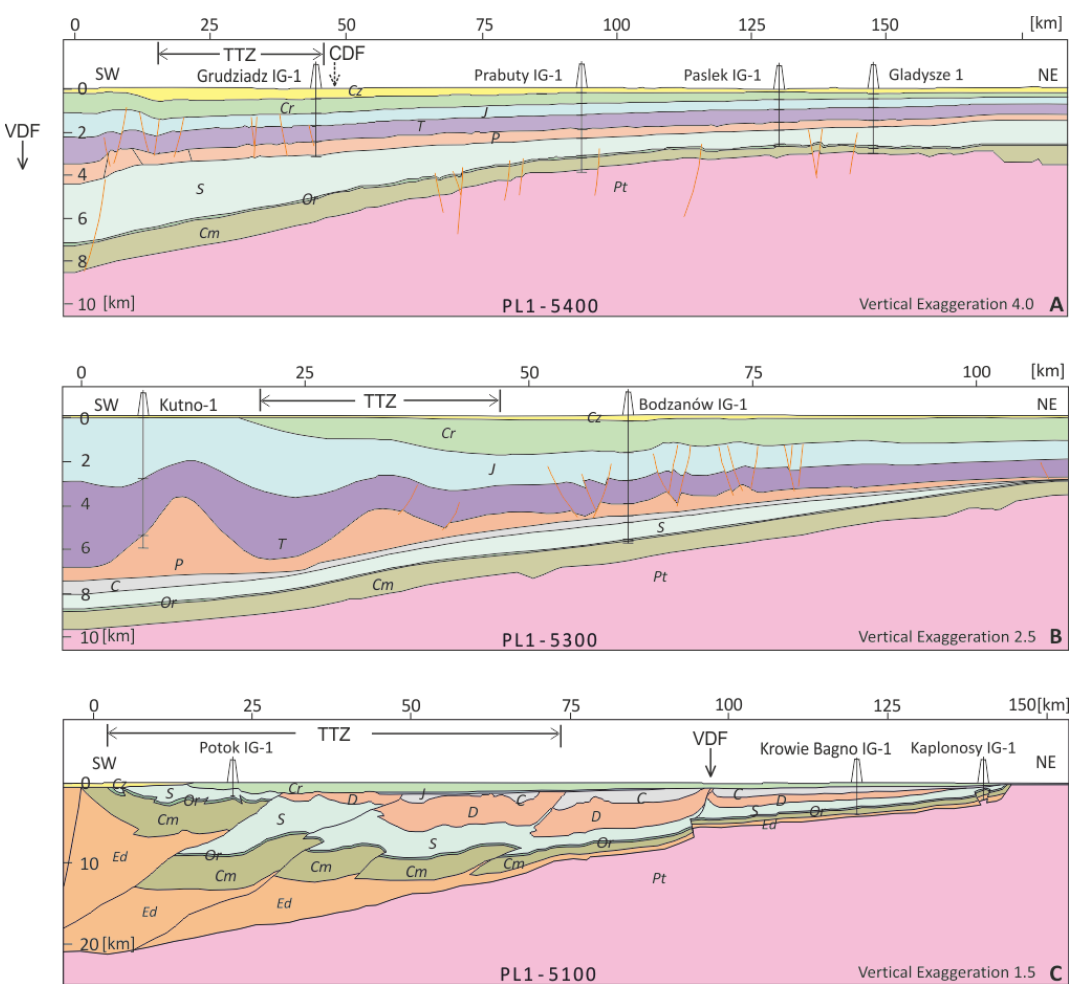
Figure 2. Vertically exaggerated geological sections across the south-western slope of the East European Platform, showing the structure of sedimentary cover and top of the crystalline basement. Cross sections are built upon the PolandSPAN™ seismic profiles PL1-5400 (a) , PL1-5300 (b) , and PL1-5100 (c) for the Baltic, Podlasie, and Lublin basins, respectively. Modified from Mazur et al. (2018a) (a) and Mazur et al. (2015) (b, c) . Abbreviations of chronostratigraphic units: Pt – Paleoproterozoic; Ed – Ediacaran; Cm – Cambrian; Or – Ordovician;